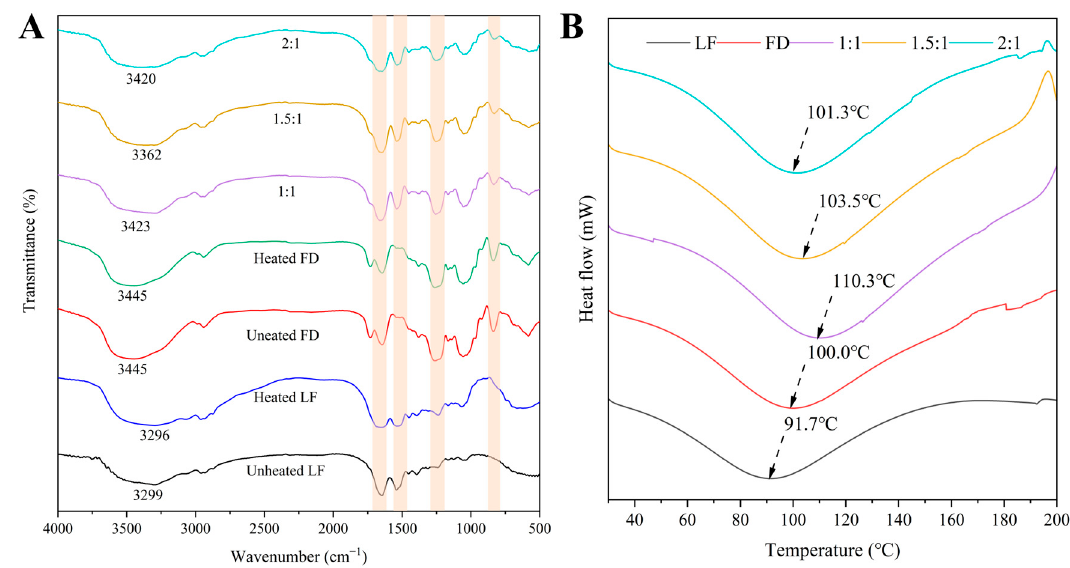
Figure 4. ( A ) FTIR spectra of unheated LF, unheated FD, and the LF–FD complexes (1:1, 1.5:1,